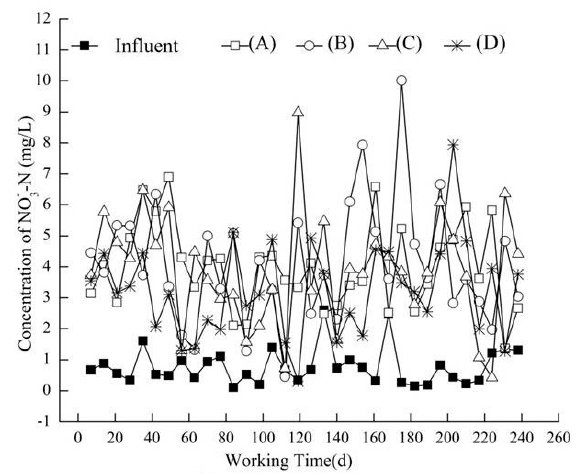
Figure 4. NO 3 − -N removal rates in the four different devices (A–D).